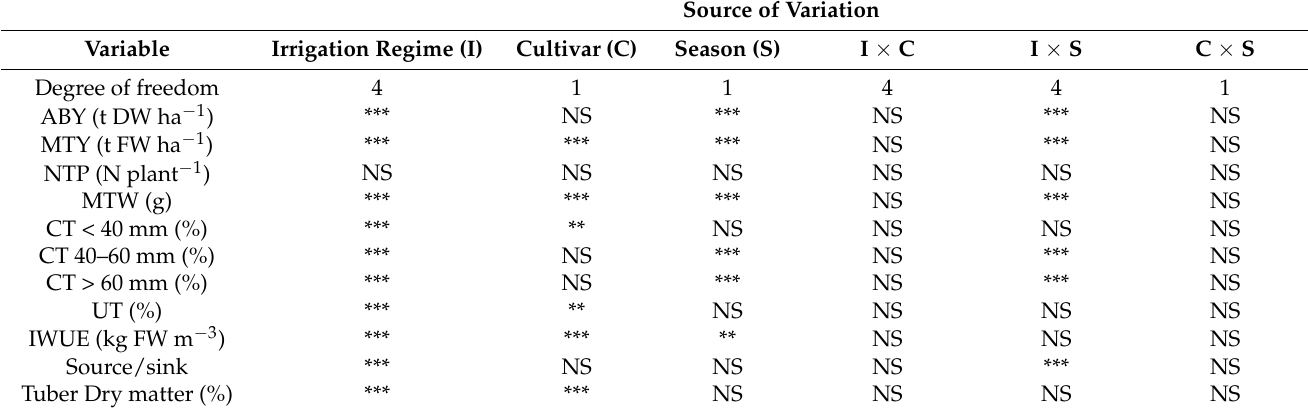
Table 5. Summary of statistical significance from ANOVA for Above-ground Biomass Yield